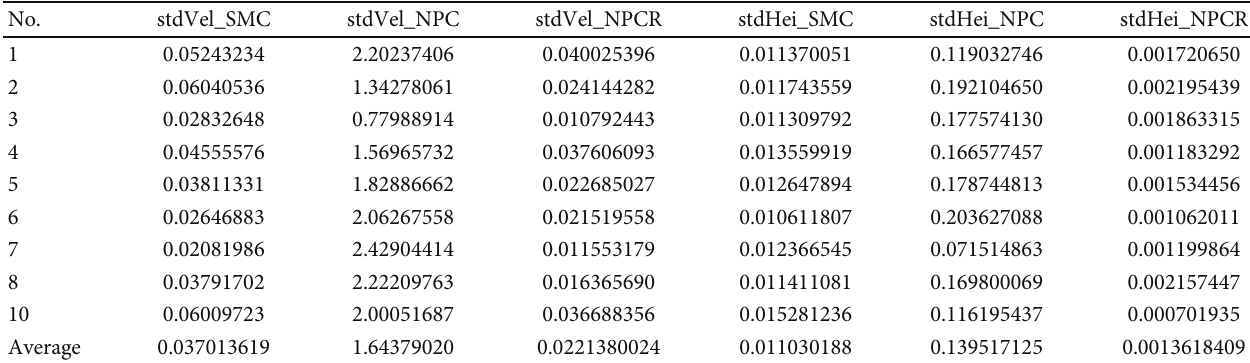
Table 3: Standard deviation comparison of di ff erent